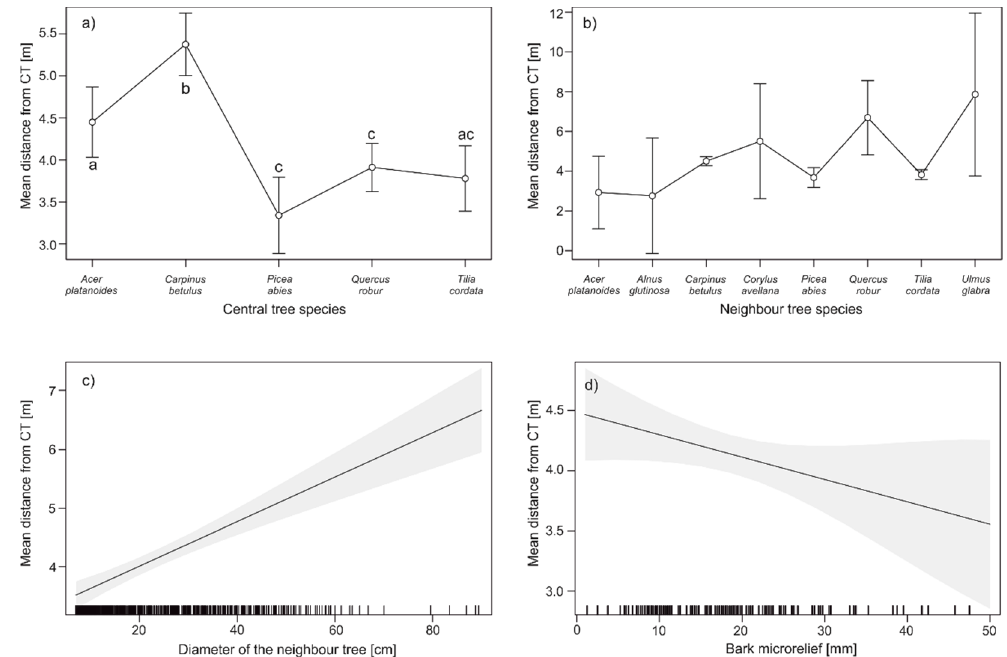
Figure 4. Dependence of the mean distance of the neighbour trees from the large central tree (CT) of the cluster from: ( a ) CT species identity; ( b ) neighbour tree species identity; ( c ) diameter of the neighbour tree; ( d ) depth of the CT bark microrelief. Table 4. Linear model ((CTdistance~CTspecies + NTspecies + NT_DBH + microrelief); Resid. SE: 3.78, Multiple R -squared: 0.1828, Adj. R -squared: 0.1677, F -statistic: 12.13 on 13 and 705 DF, p < 2.2